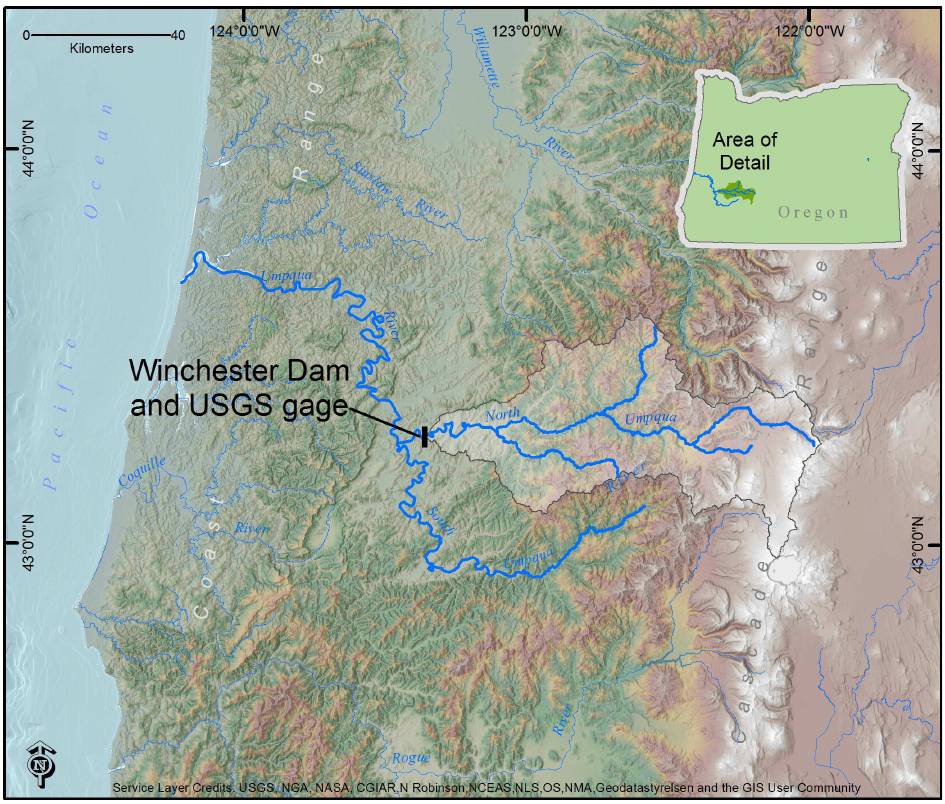
Fig 2. Location of Winchester Dam, OR, and upstream drainage basin. Winchester Dam was built in 1890 and upgraded in 1907and now includesa timber-crib structure that is 4.9 m in height. While the dam does impounda shallowupstream reservoir, it is considered a “run-of-river”dam. A fish ladderallowingfish passagewas installedin 1945 with a viewingwindowto monitor the upstream passageof all fishes past the dam. Continuously collectedfish passagedata at this location from 1992 and 2013 was used to developthe Winchester Dam